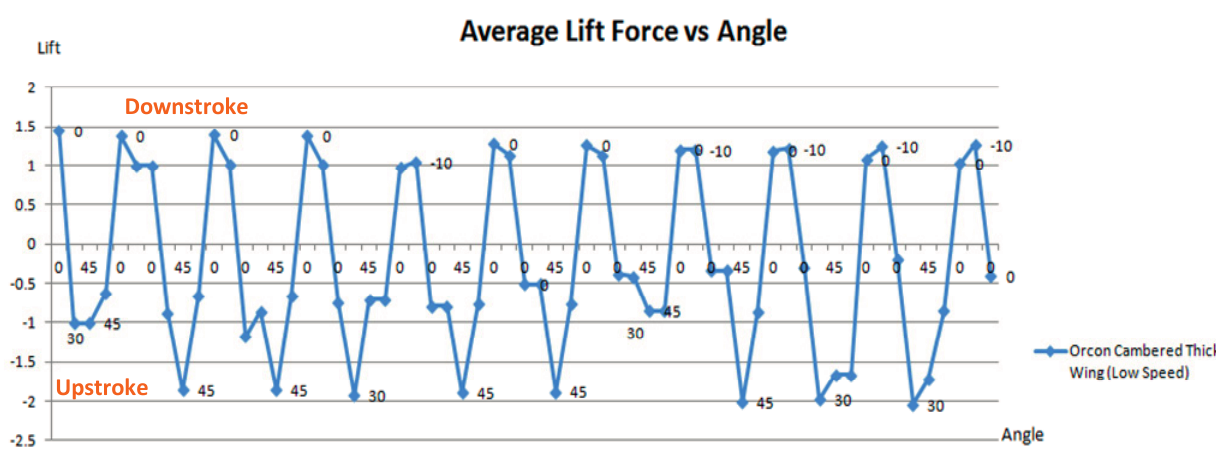
Figure 37. Orcon cambered thick wing lift against time (10 full cycles).